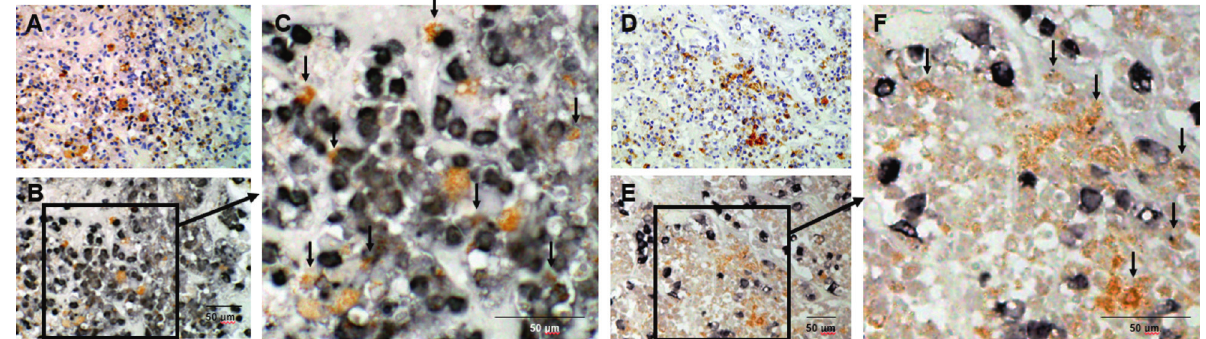
Figure 3: Double staining of (pro)renin receptor and growth hormone or adrenocorticotropic hormone. (A), (D) (Pro)renin receptor staining counterstained with hematoxylin; (B) double staining of (pro)renin receptor and growth hormone in the identical section as (A); (C) high-power field of (B); (E) double staining of (pro)renin receptor and adrenocorticotropic hormone in the identical section as (D); and (F) high-power field of (E). Arrows indicate cells costained with (pro)renin